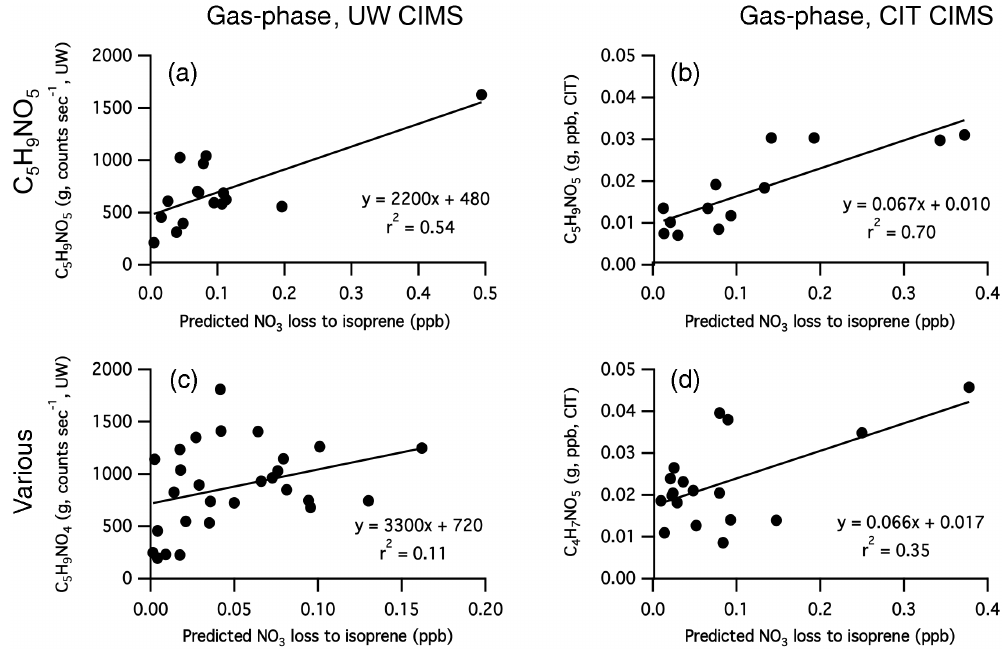
Figure 8. Gas-phase CIMS data correlated to predicted isoprene + NO 3 , during periods of buildup of these C 5 and C 4 nitrates as measured by each CIMS. Panels (a) and (b) show C 5 H 9 NO 5 , which is well correlated to predicted isoprene + NO 3 suggesting this is a NO 3 gas-phase product, with the calibrated mixing ratios measured by CIT enabling estimation of an approximate lower limit molar yield of 7%. Panel (c) shows that C 5 H 9 NO 4 is poorly correlated to isoprene + NO 3 suggesting that this product comes (at least in part) from another oxidative source (ex. RO 2 +NO). Panel (d) , C 4 H 7 NO 5 , also shows a poorer correlation than panels (a) and (b) , suggesting it is not exclusively a product of NO 3 oxidation, or has rapid